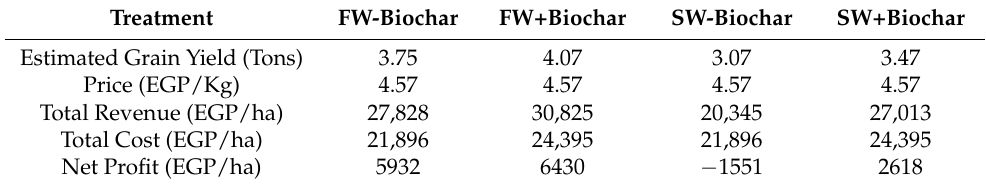
Table 7. Wheat profitability analysis for each treatment/hectare area. Treatment FW-Biochar FW+Biochar SW-Biochar SW+Biochar Estimated Grain Yield (Tons)